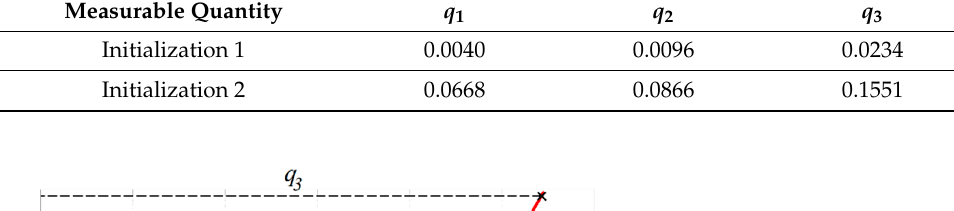
Table 2. Sensitivity of measurable quantities to cohesion ( d ) at relative density 0.95.